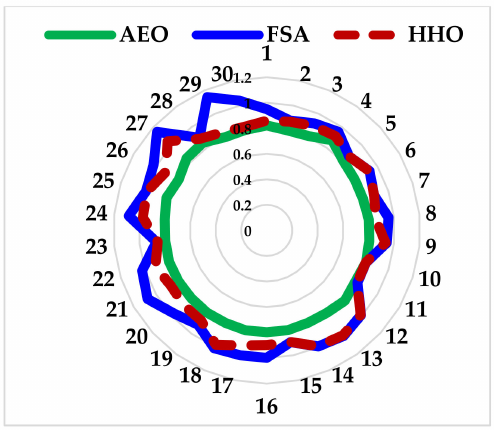
Figure 12. Fitness for cost of energy with DSM at 60% REF and 0%